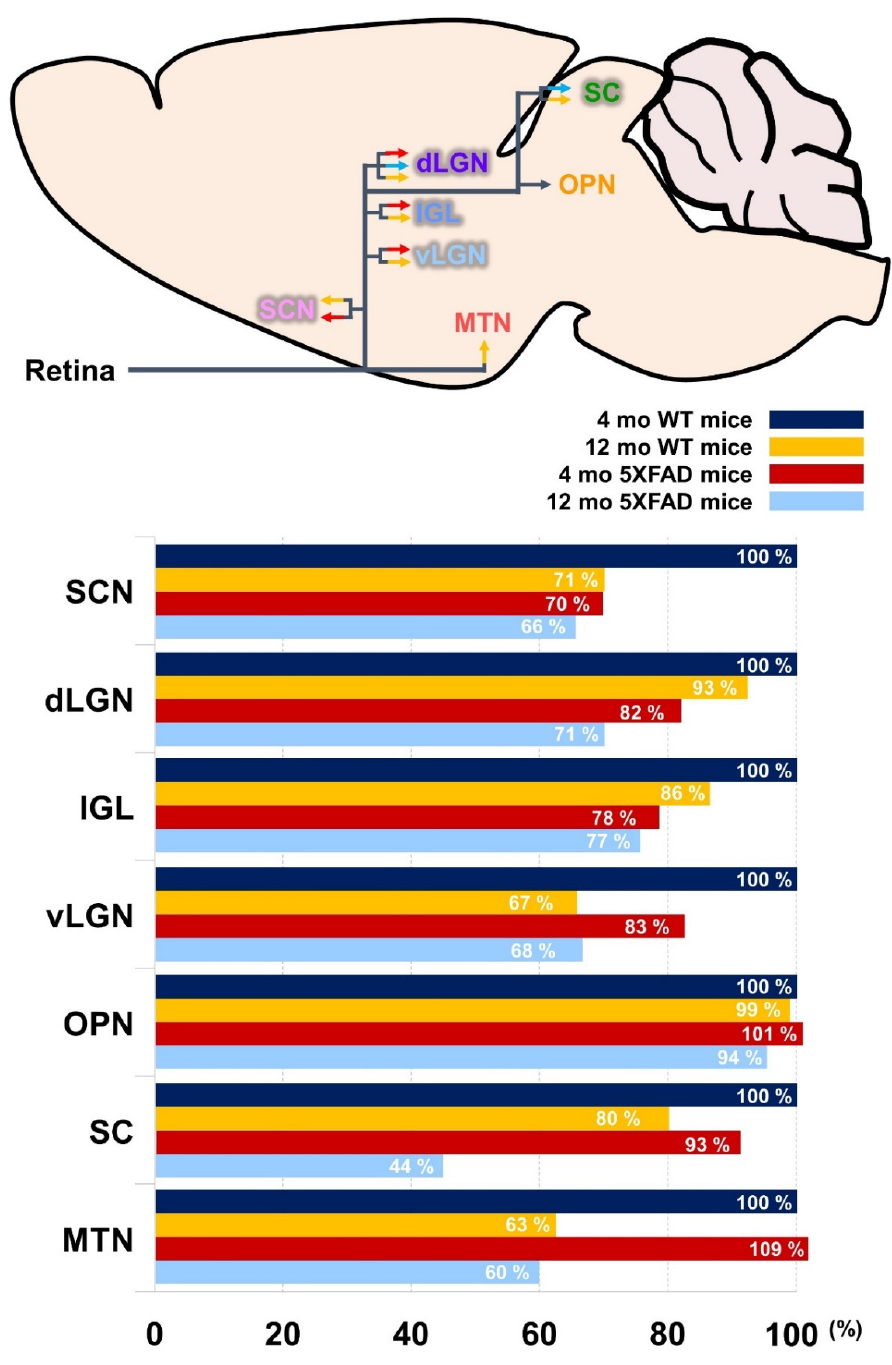
Figure 10. Schematic drawing and quantitative analysis of the altered visual pathways from the retina to the retinorecipient regions. The rate of degeneration of the visual pathways was normalized to those of 4-month-old WT mice indicated by the black bars. Red bars displayed regions that are impaired in early stage of AD. Blue bars indicate the damaged regions in late-stage of AD. Orange bars show regions damaged by aging.